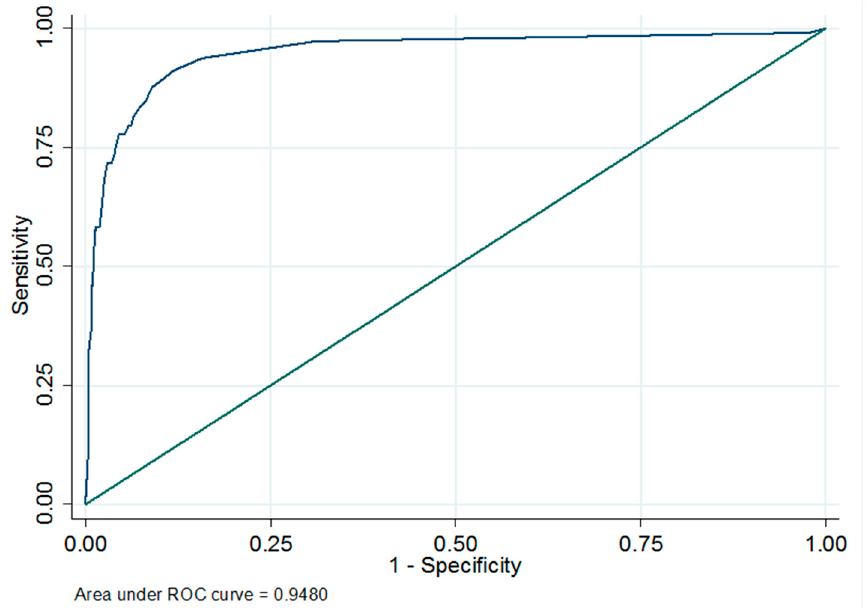
Figure 1. Receiver operating characteristic ROC curve and corresponding area under curve of Mycobacterium avium subsp. paratuberculosis (MAP) milk ELISA results as compared to serum ELISA results in Dutch dairy goats ( n = 992).